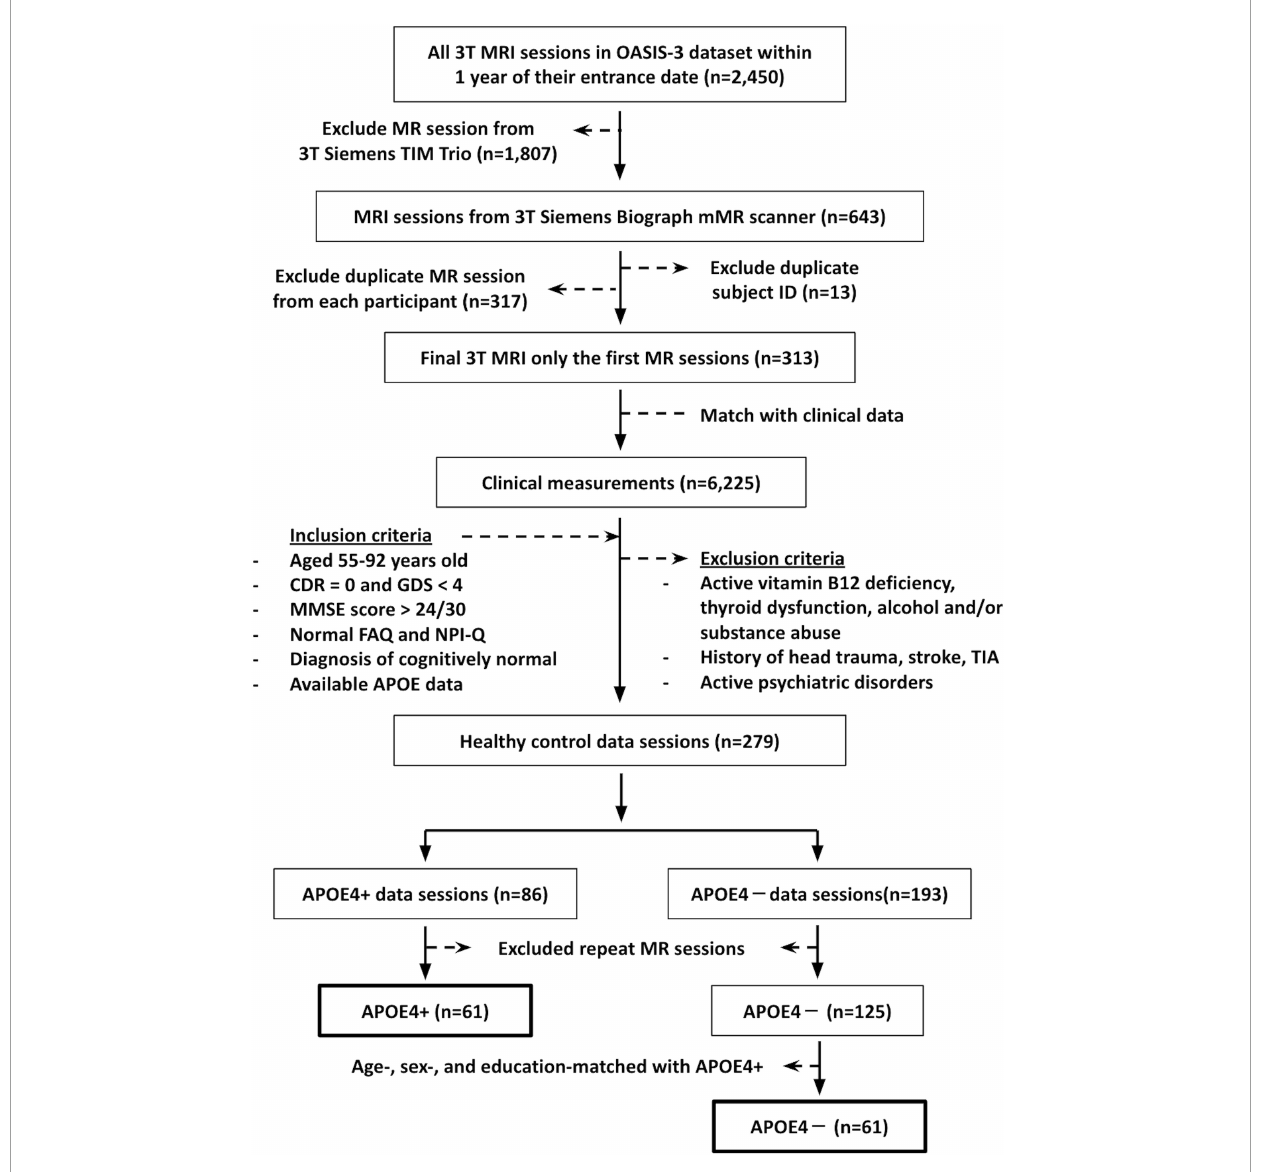
FIGURE1 The summary flowchart of the recruitment of participants from the open-access series of imaging studies (OASIS-3) database. CDR, Clinical Dementia Rating; GDS, Geriatric Depression Scale score; MMSE, Mini-Mental State Exam score; FAQ, Functional Activities Questionnaires; NPI-Q, The Neuropsychiatric Inventory–Questionnaire; TIA, transient ischemic